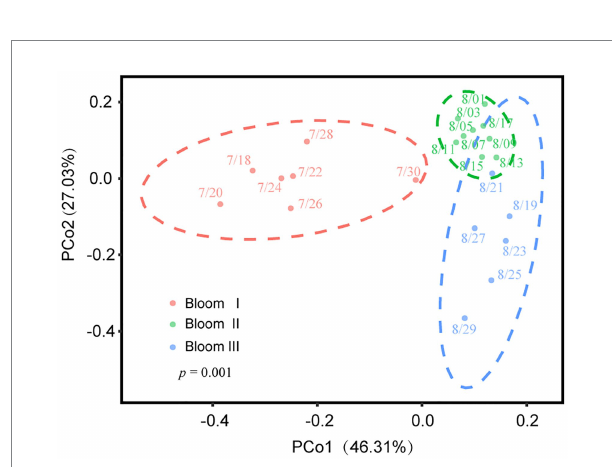
FIGURE 3 Variation in beta diversity visualized using principal coordinate analysis (PCoA). Different color regions represented the 95% bootstrapped confidence ellipses of each bloom stage. The PERMANOVA test determined that phytoplankton communities diverged significantly in these three stages ( p =